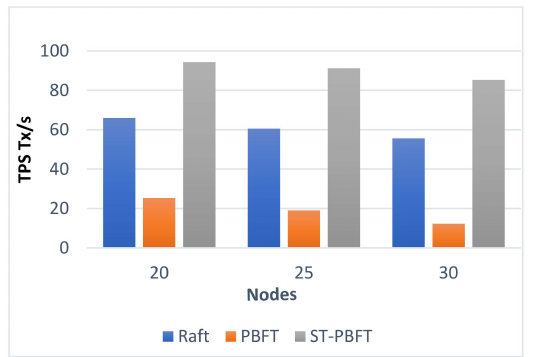
Figure 11. TPS comparison of three consensus algorithms.